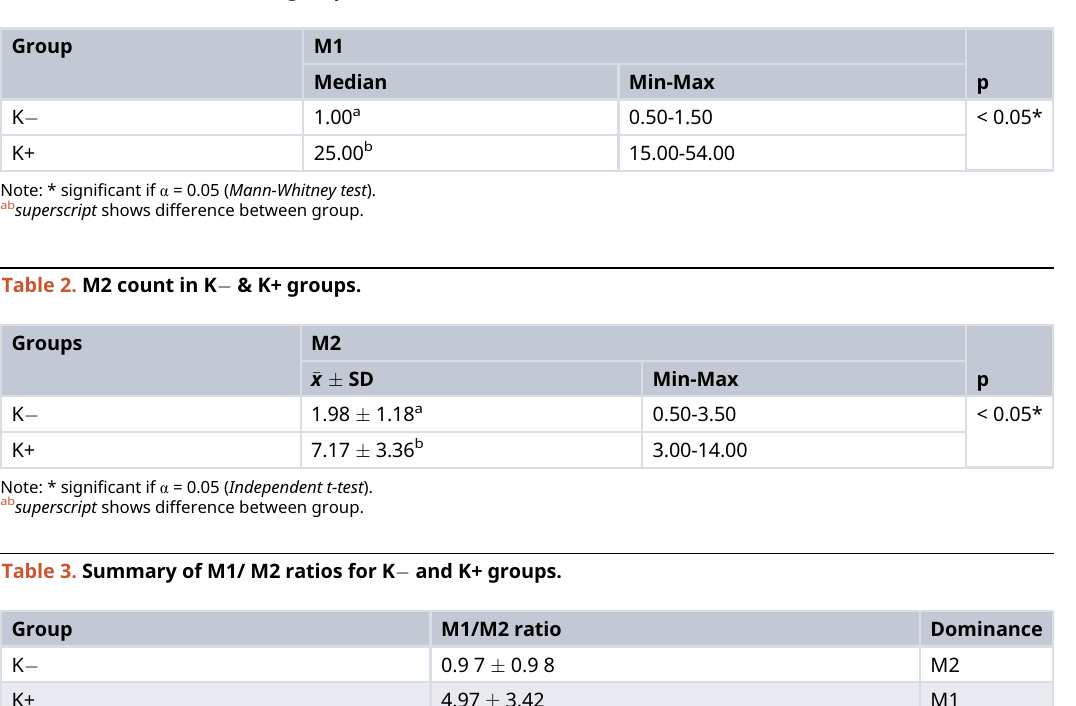
Table 1. M1 count in K (cid:2) & K+